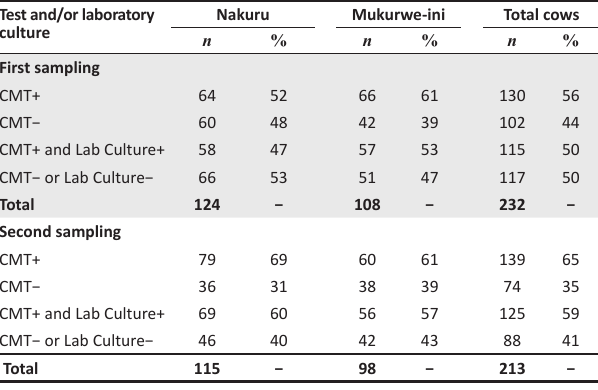
TABLE 3: Results of the California Mastitis Test and laboratory cultures at the cow-level of the first and second dairy farm visit in Mukurwe-ini and Nakuru Districts, Kenya, June 2010 to August 2010.